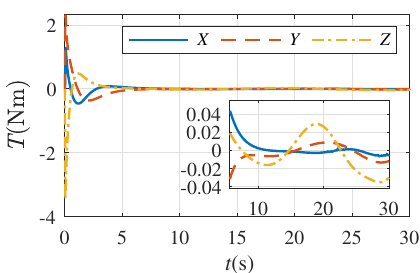
Figure 11. Control torque of